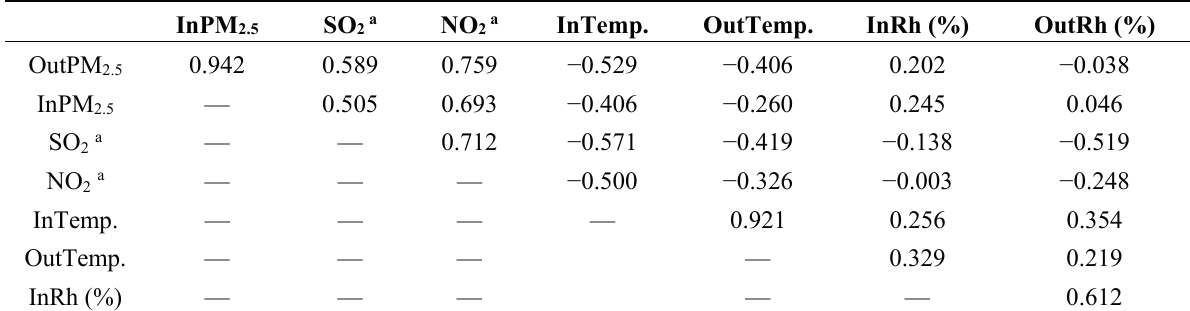
Table 3. Spearman correlation coefficients for pollutants and meteorological